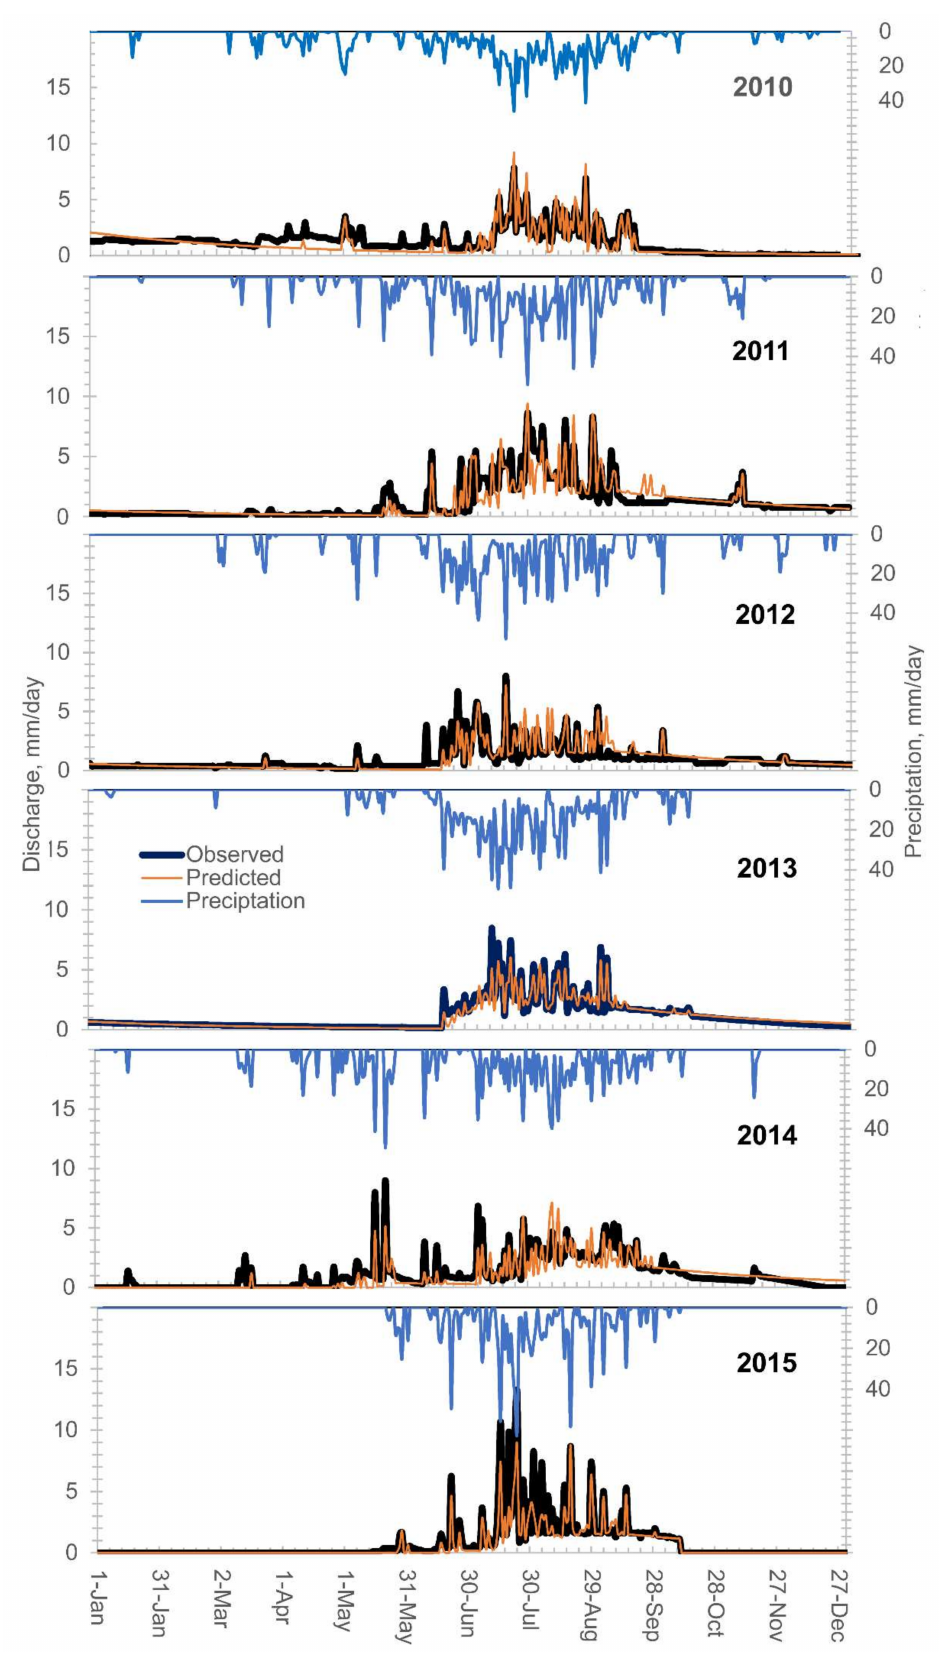
Figure 3. Daily rainfall observed and predicted runo ff of the model hydrograph of the Tikur-Wuha watershed from 2010 to